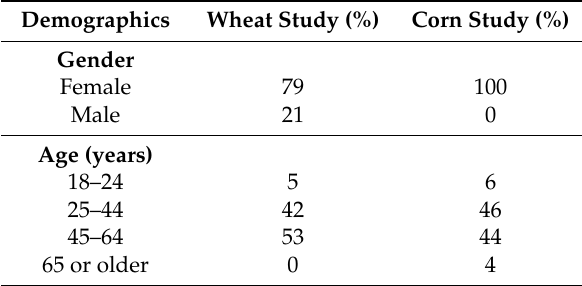
Table 1. Demographic information of 43 wheat dough preparers and 50 corn dough preparers who participated in the studies.